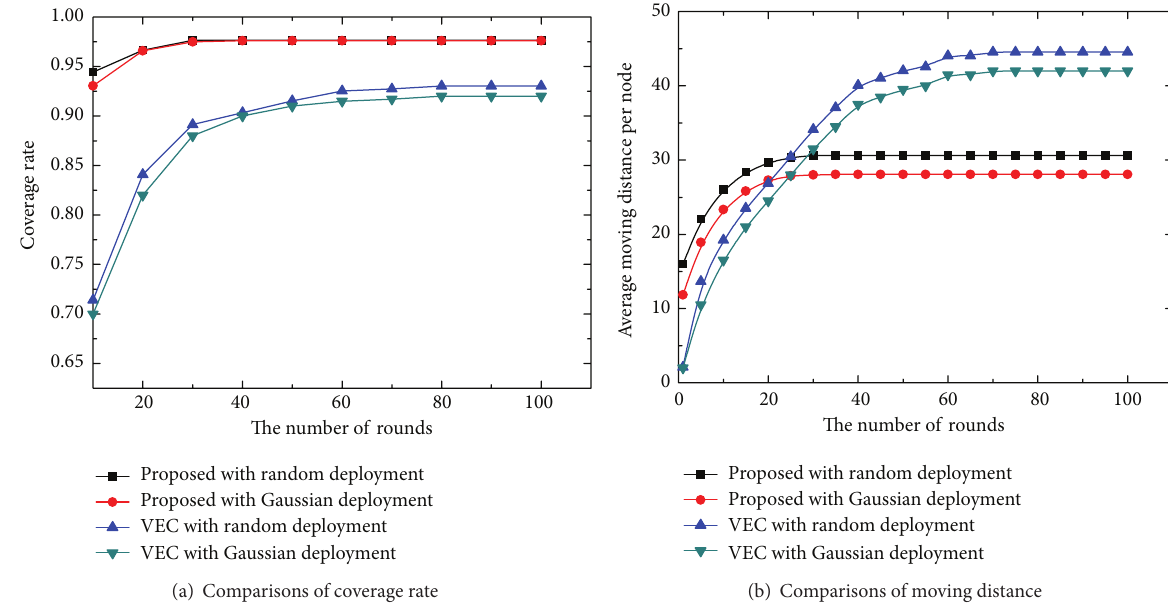
Figure 6: Comparisons of network performance in different